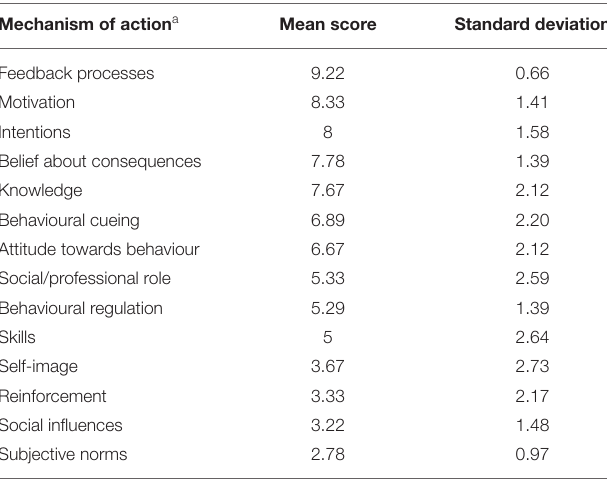
TABLE 7 | Mean score (0–10) for the 14 mechanisms of action statements explored in the process evaluation interviews with University students ( n =